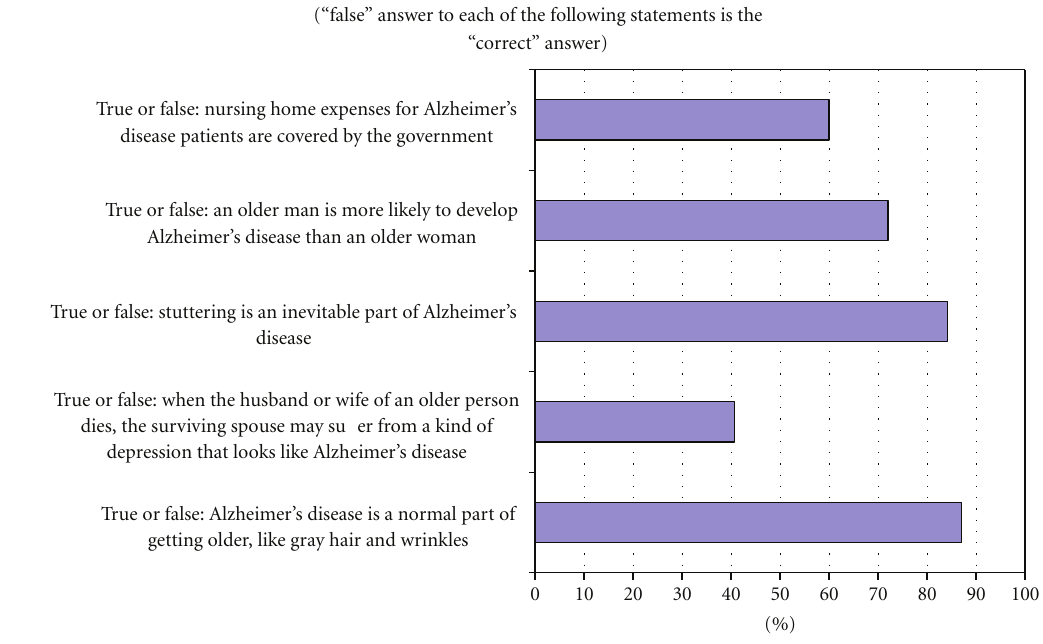
Figure 1: Alzheimer’s disease knowledge test (ADKT) (weighted results).